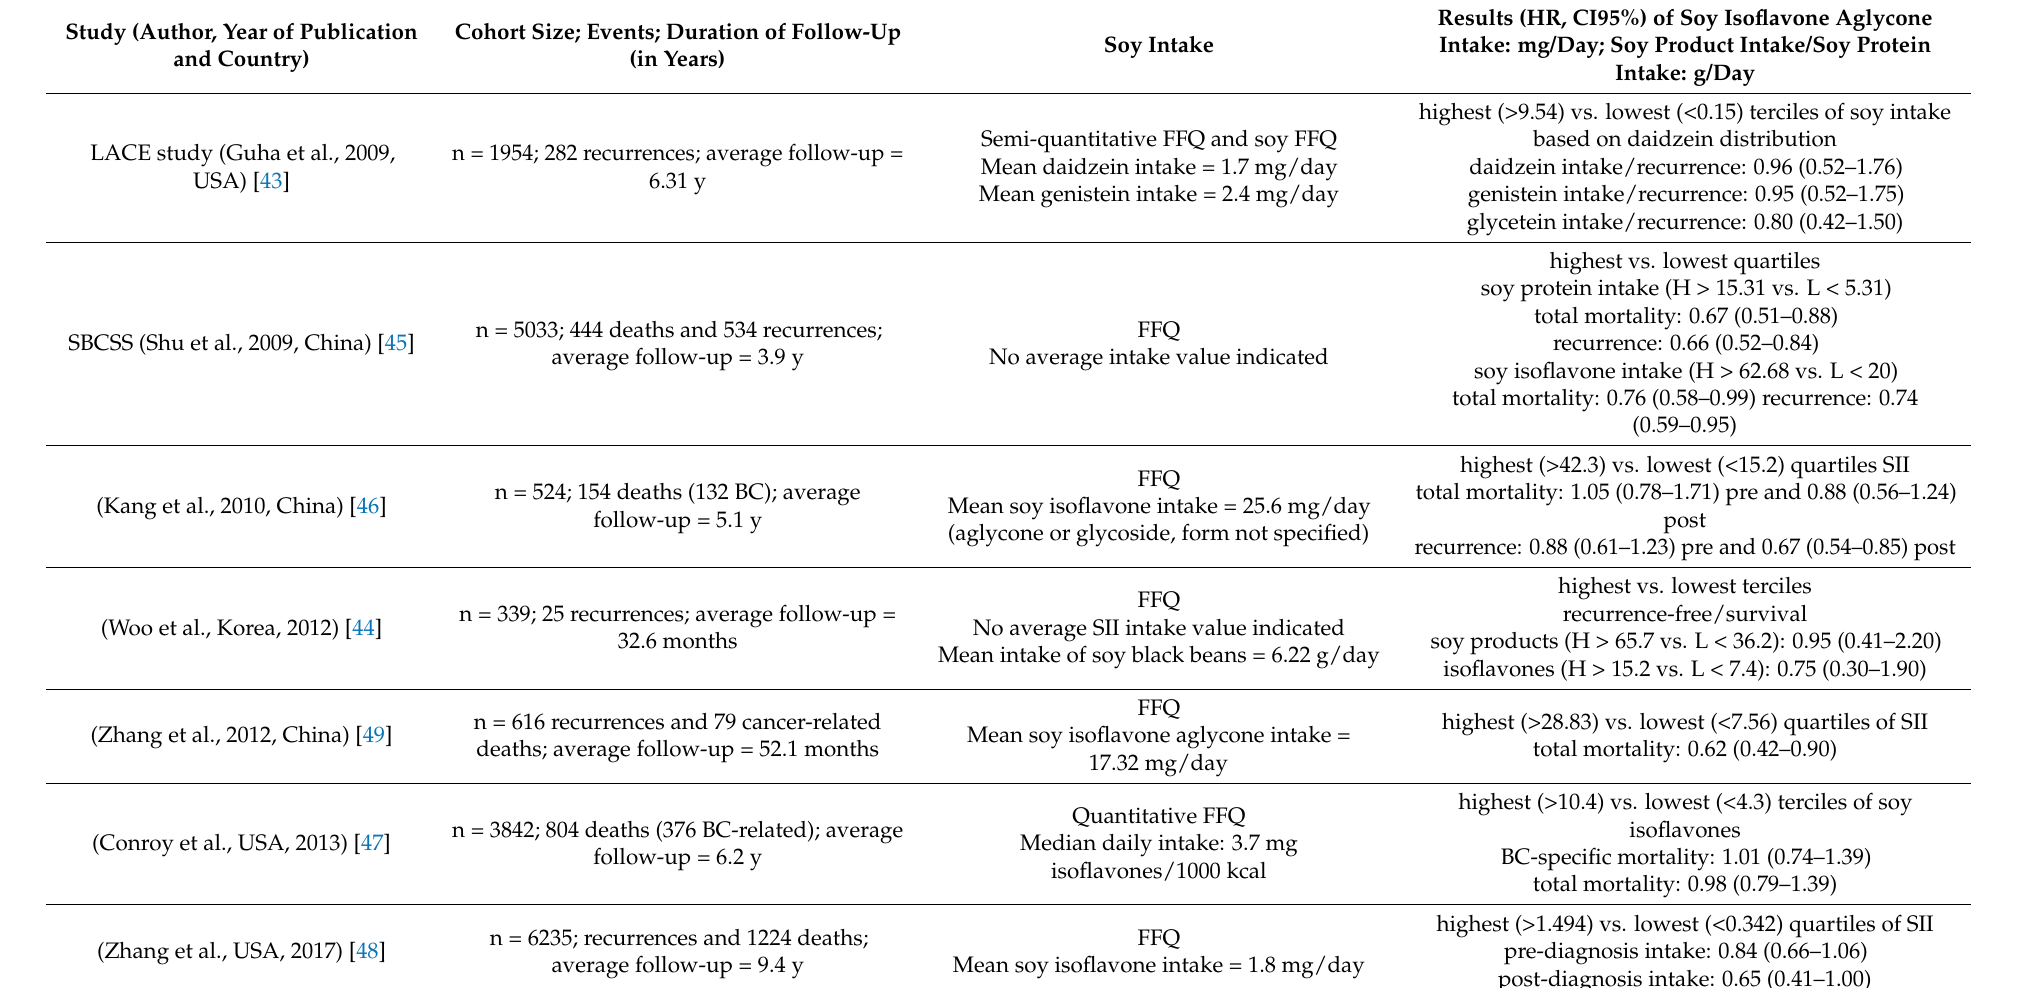
Table 4. Characteristics of studies on the association between soy food intake and